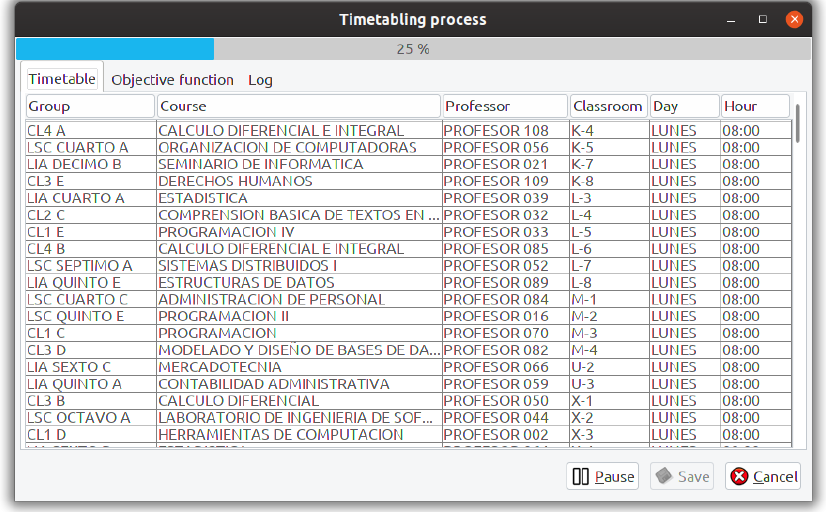
Figure 15. Timetable